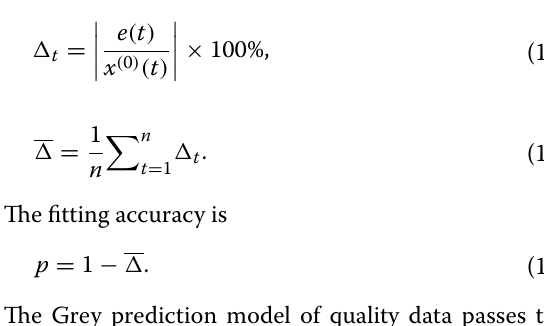
The Grey prediction model of quality data passes the residual test if p is greater than 80%.